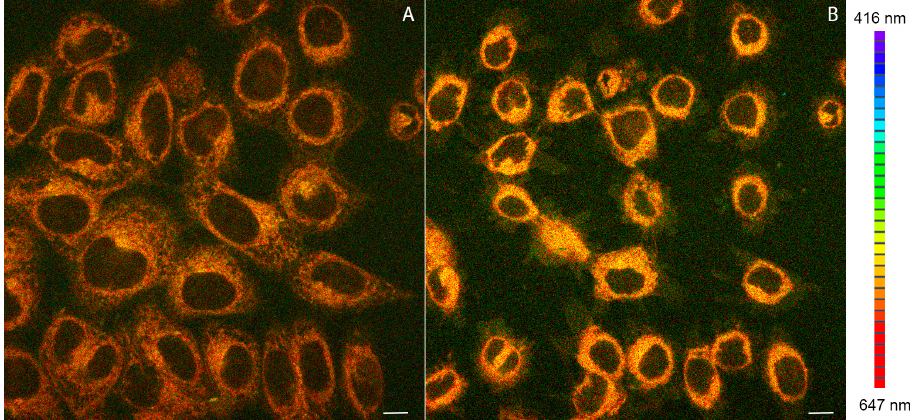
Figure 5. ( A ) Confocal luminescence image of living HeLa cells stained with 2 ; ( B ) View of the photocytotoxic effect of 2 on HeLa cells after prolonged laser irradiation at 405 nm. Emission wavelengths are represented using a false color scale (right), with colors corresponding to spectral bands (416–647 nm total range). Scale bar 10 µm.